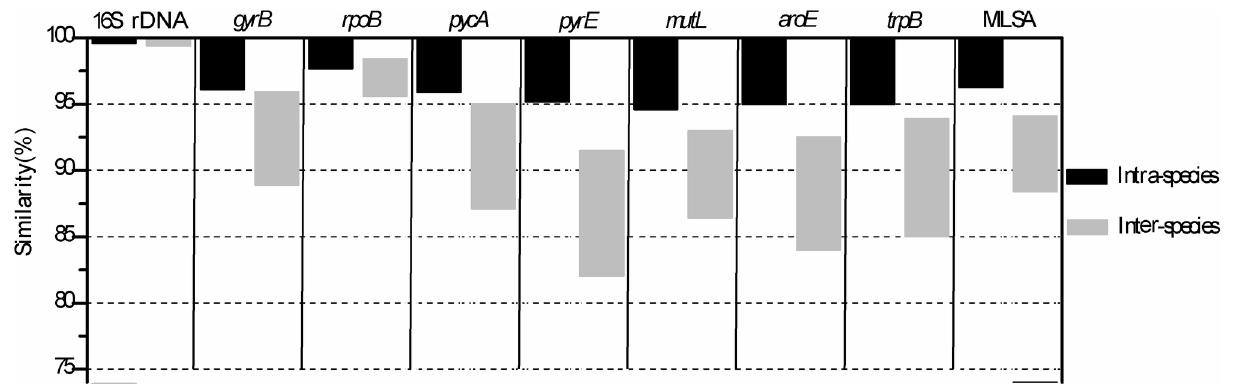
Figure 2. Intraspecies and interspecies similarity ranges of housekeeping genes in the B. pumilus group. doi: